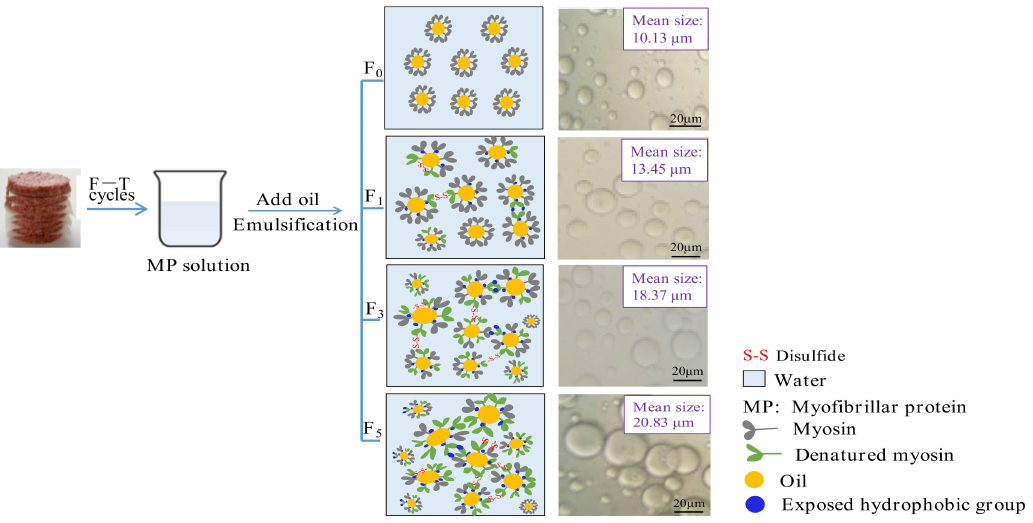
Figure 6. Proposed schematic illustration for the decreased emulsifying property of protein during F–T cycles caused by protein aggregation and